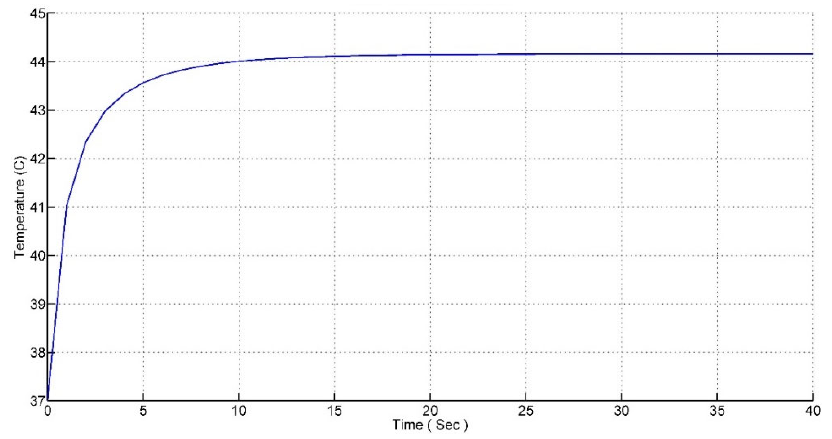
Figure 10. Step response of the pole placement controller.